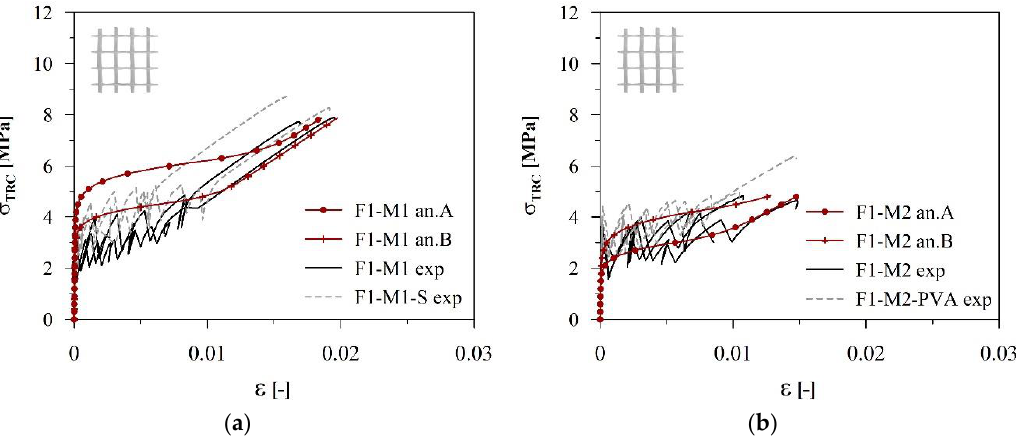
Figure 16. Comparison between the predicted analytical curves and the experimental responses in terms of nominal stress vs. strain for M1-based ( a ) and M2-based ( b ) composites reinforced with Fabric F1.